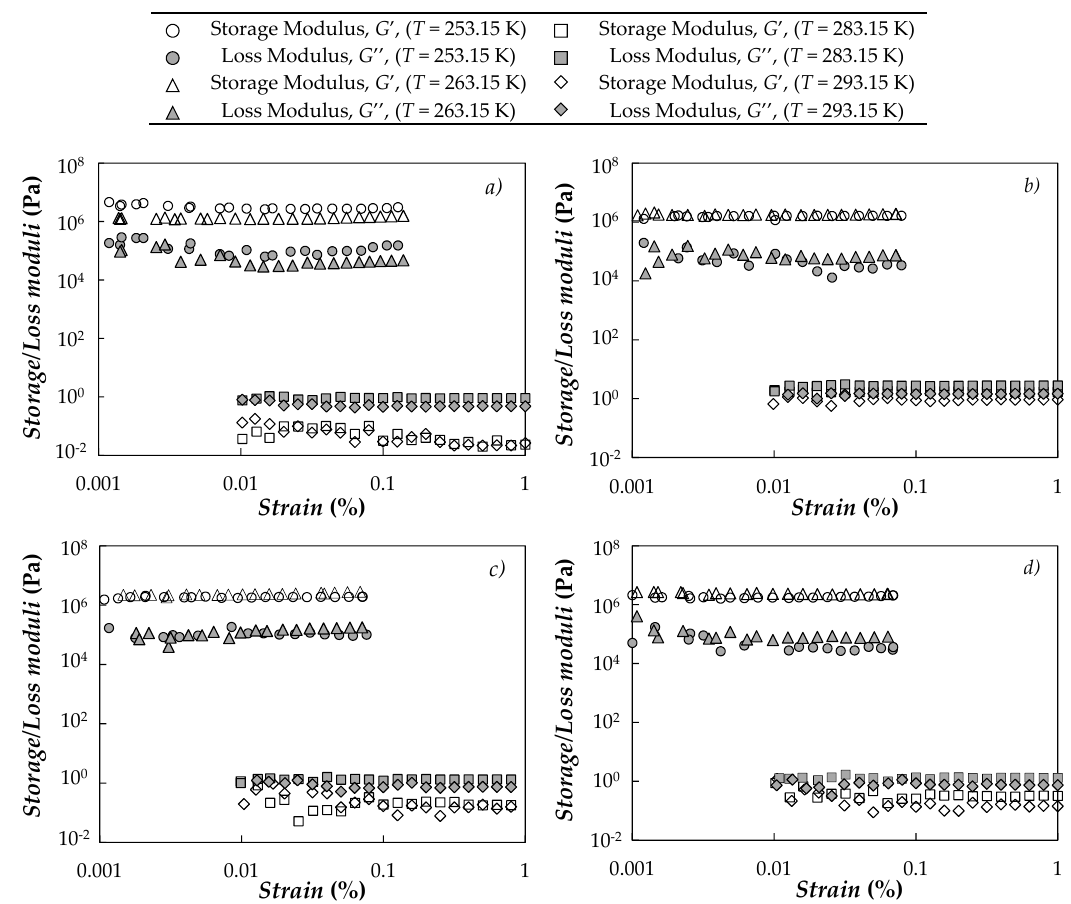
Figure 3. Storage and loss moduli as a function of strain obtained for ( a ) neat PEG400 as well as ( b ) CB (1 wt.%)/PEG400, ( c ) nD87 (1 wt.%)/PEG400 and ( d ) G/D-p (1 wt.%)/PEG400 nanofluids. Oscillatory frequency was kept constant at 1 Hz.